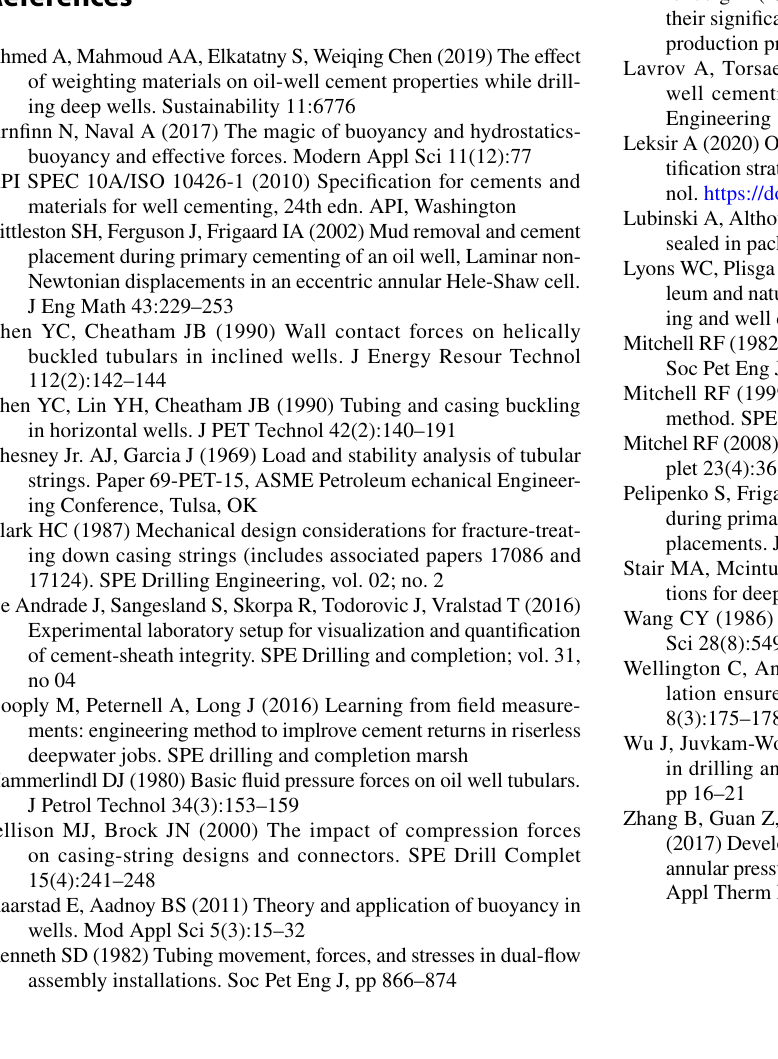
Chart surface pressure (psi), just before reaching